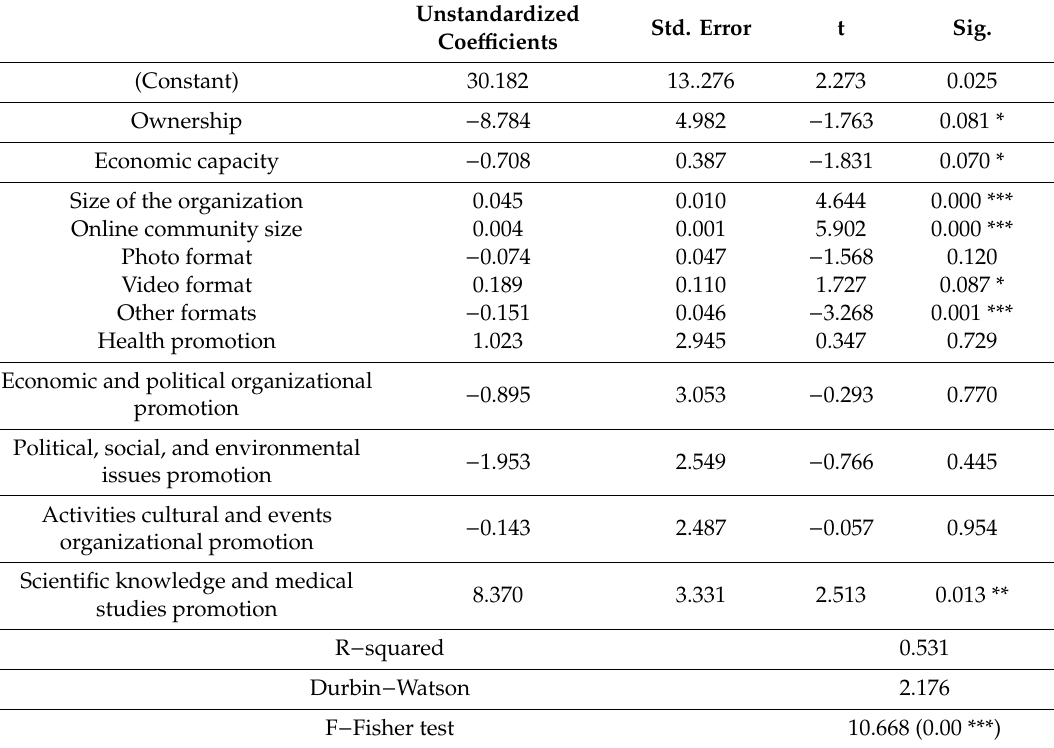
Table 6. Results of the Regression